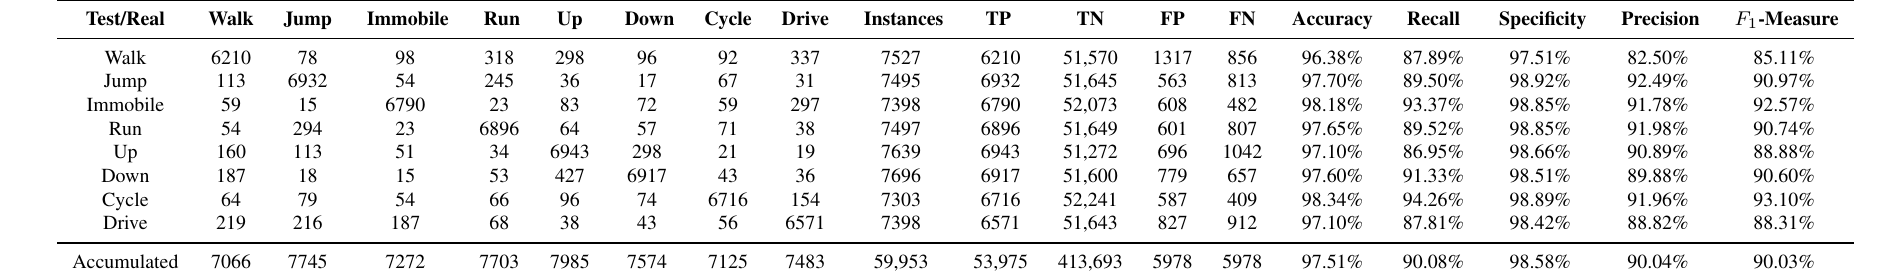
Table B3. Confusion matrix and performance values for the C4.5-based classification